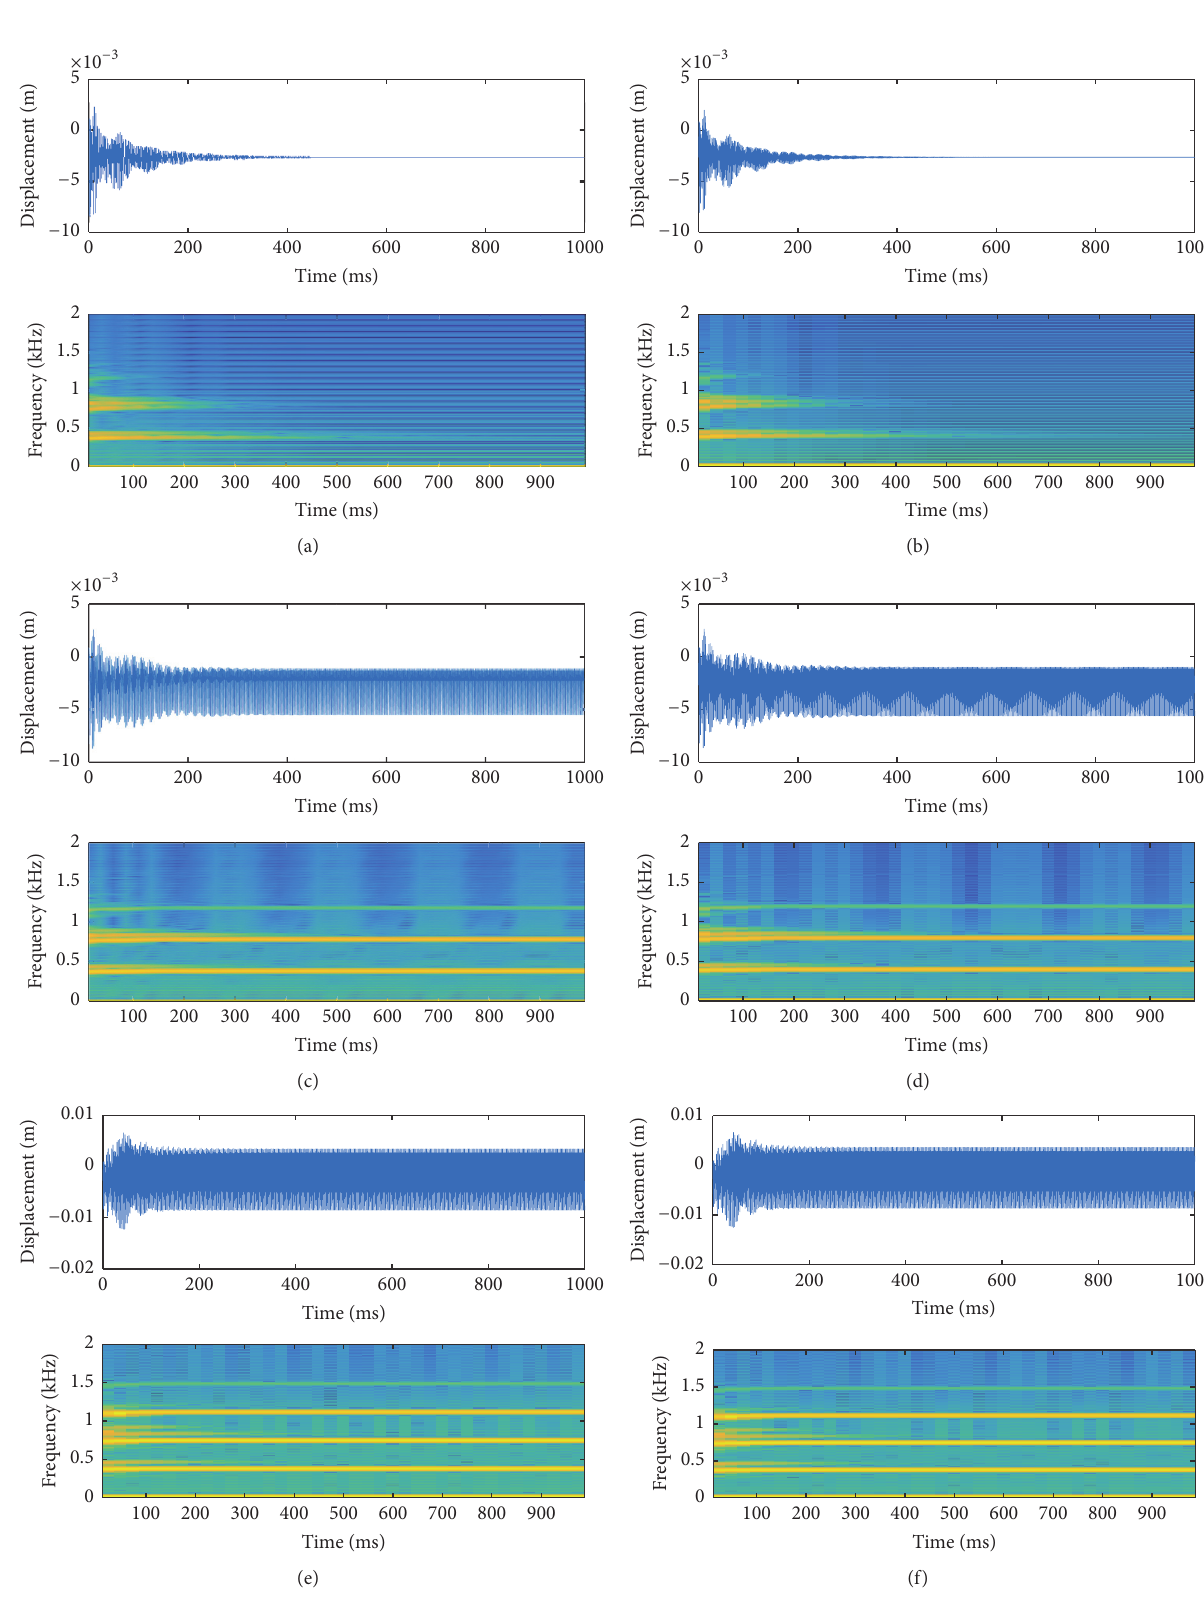
Figure 3: Transient simulations and spectrograms for one degree-of-freedom of the disc at the normal component: (a, b) 𝜇 = 0.4 , (c, d) 𝜇 = 0.5 , (e, f) 𝜇 = 0.6 , (a, c, e) reference, and (b, d, f) reduced model with 15 interface